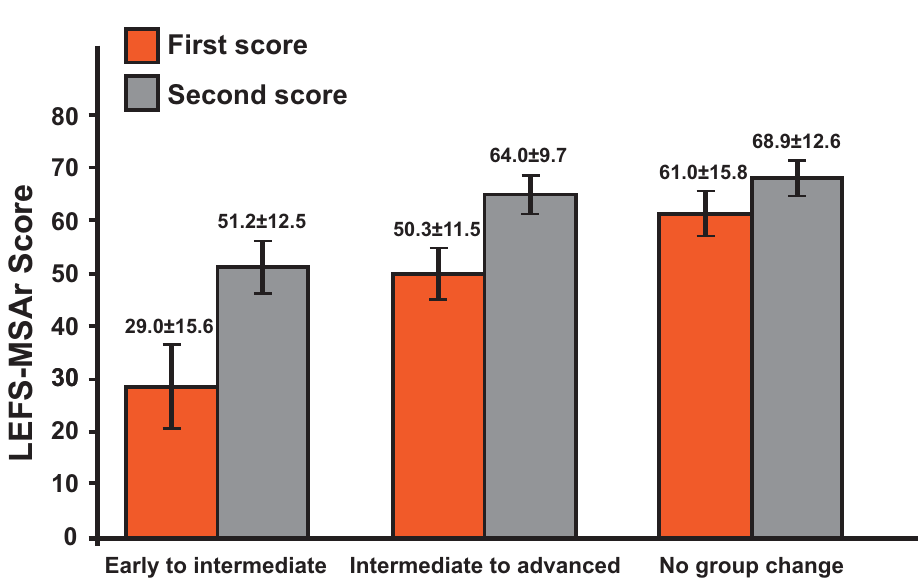
Fig 6. Mean LEFS-MSAr scores over 2 months. Mean LEFS-MSAr scores over a two-month test-retest, grouped by independently rated ACL rehabilitation group. Abbreviations: LEFS-MSAr, lower extremity functional scale modern standard Arabic